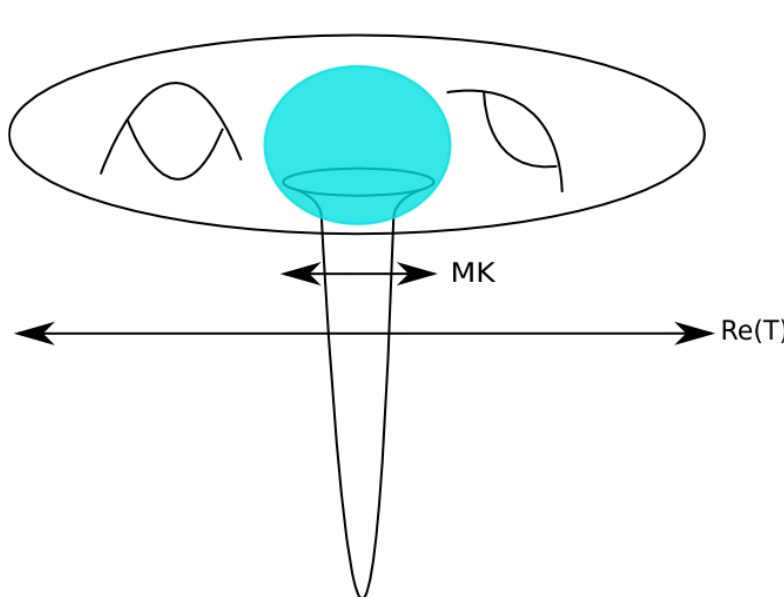
Figure 3 . We depict a cartoon of a CY that contains a warped throat region. For geometrical consistency the throat region must be smaller than the overall size of the